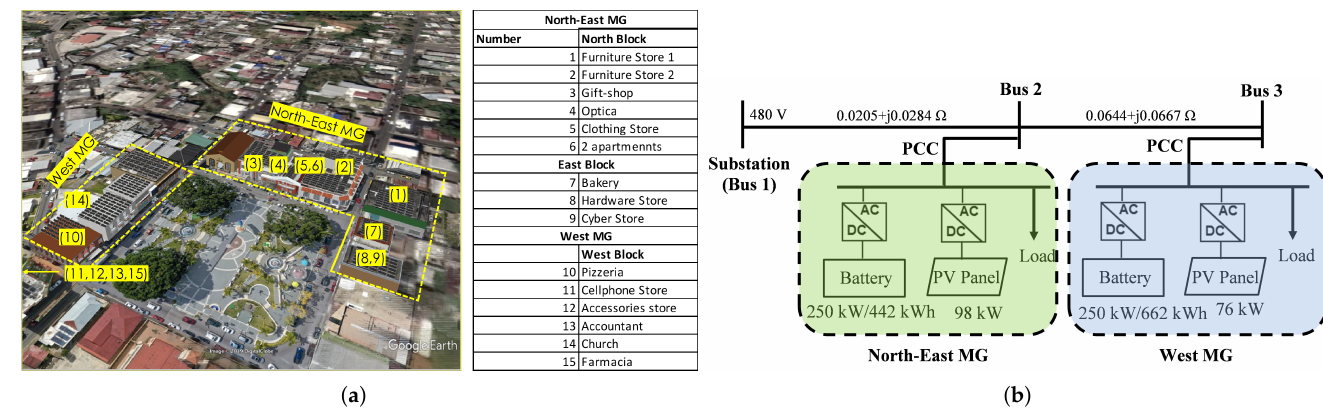
Figure 11. Adjuntas networked microgrids. ( a ) 3D renderings of two microgrids in Adjuntas, Puerto Rico. ( b ) Adjuntas networked microgrids diagram.